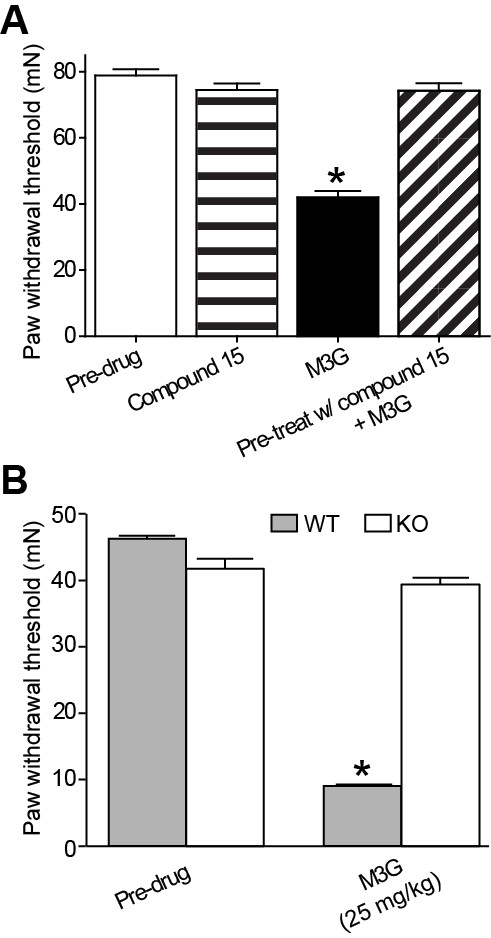
Systemic morphine-3-glucuronide administration fails to elicit tactile hyperalgesia in rats pretreated with the small molecule inhibitor of Toll-like receptor 4/myeloid differentiation protein-2 complex, Compound 15, or in Toll-like receptor 4 knockout mice. (A) Systemic morphine-3-glucuronide (M3G) (10 mg/kg, intraperitoneally) produced robust tactile hyperalgesia (n = 6, ANOVA, Bonferroni multiple comparison test, *P < 0.05), which could be prevented by pretreatment with Compound 15 (10 mg/kg, intraperitoneally, n = 6). (B) Shown is the force necessary to elicit paw withdrawal in Toll-like receptor 4 (Tlr4) wild-type and Tlr4 knockout mice. Systemic M3G (25 mg/kg, intraperitoneally) produced robust tactile hyperalgesia in Tlr4 wild-type mice (n = 6, *P < 0.05). Tlr4 knockout mice failed to display a decrease in paw withdrawal force following systemic M3G (n = 6).